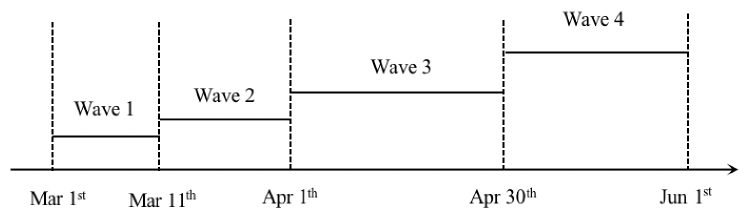
Figure 2. Observation waves during the pandemic.